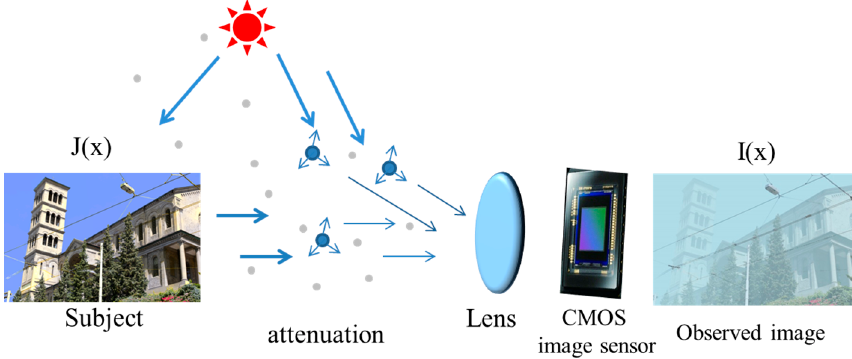
Figure 1. Image degradation model of the Complementary Metal-Oxide-Semiconductor (CMOS) image sensor.